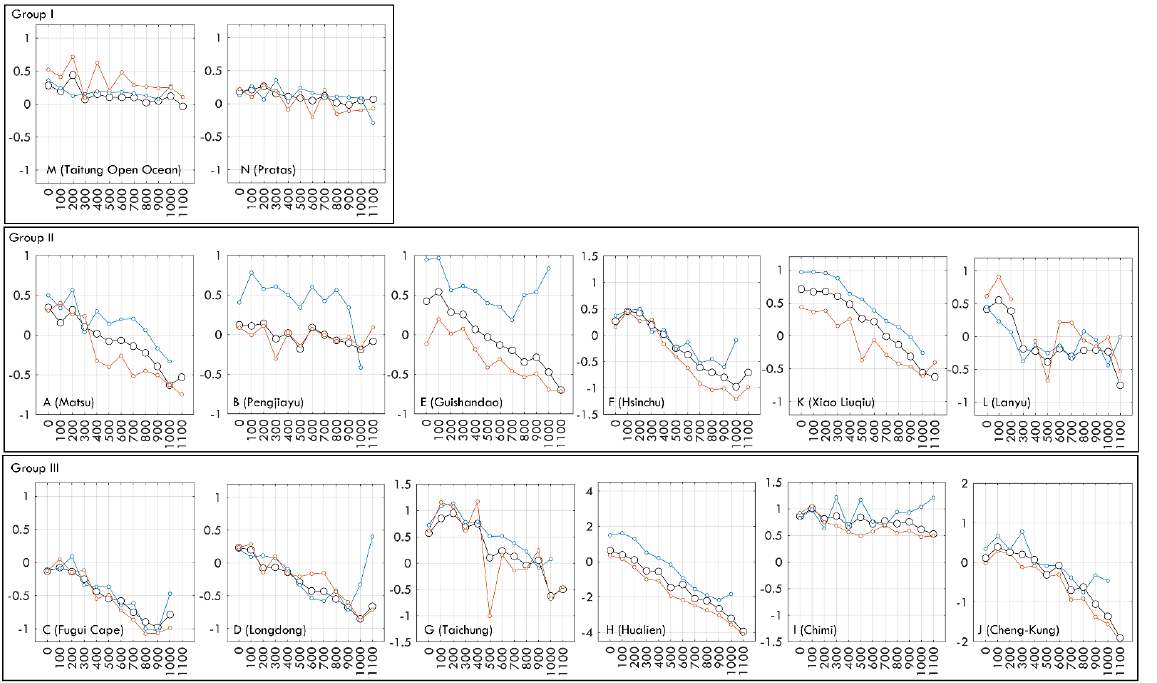
Figure 9. The effect of solar insolation on ocean near-surface temperature. The horizontal axis is solar shortwave radiation (W/m 2 ), 0 represents nighttime radiation, and 100 represents shortwave radiation in a range of 0 to 100. The vertical axis is the bias of bulk SST minus skin SST (°C). The black line represents all data, the blue line is winter (December – March), and the red line is summer (June – September).